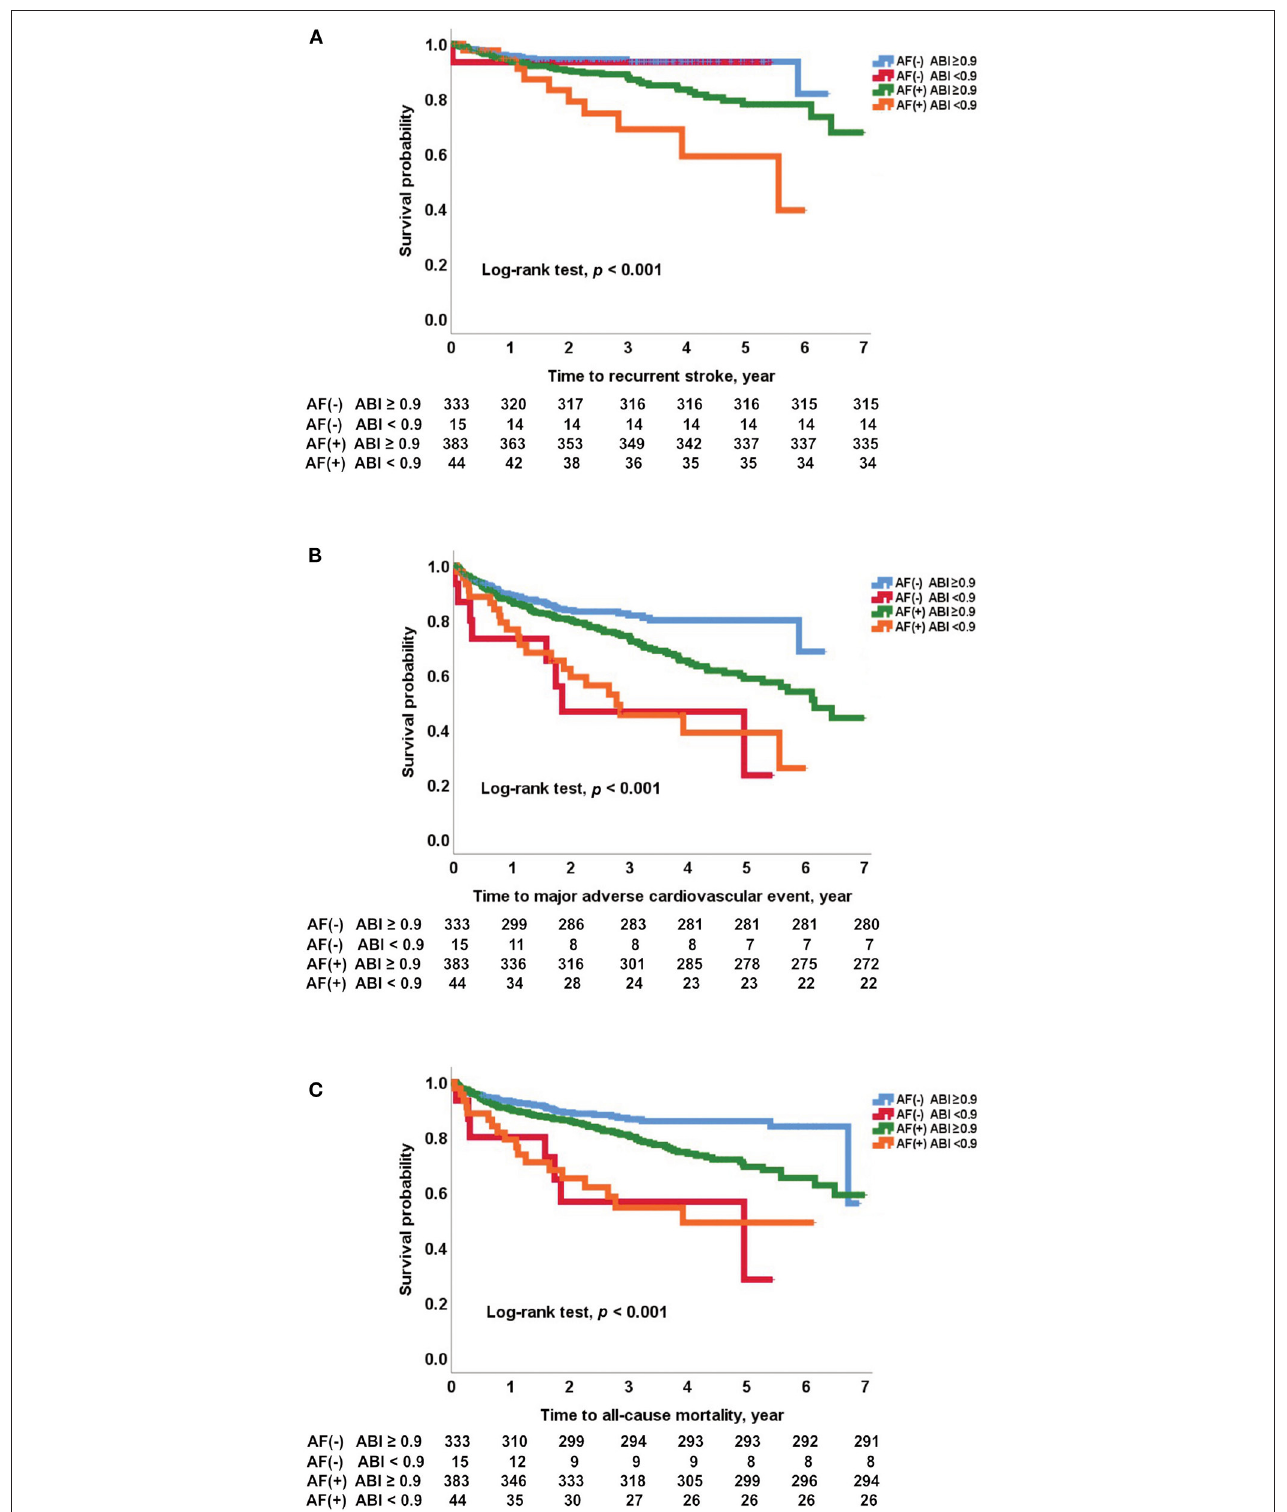
FIGURE 4 | Kaplan-Meier survival analysis for (A) recurrent stroke, (B) major adverse cardiovascular events, and (C) all-cause mortality according to AF and an ABI < 0.9. ABI, ankle-brachial index; AF, atrial fibrillation.